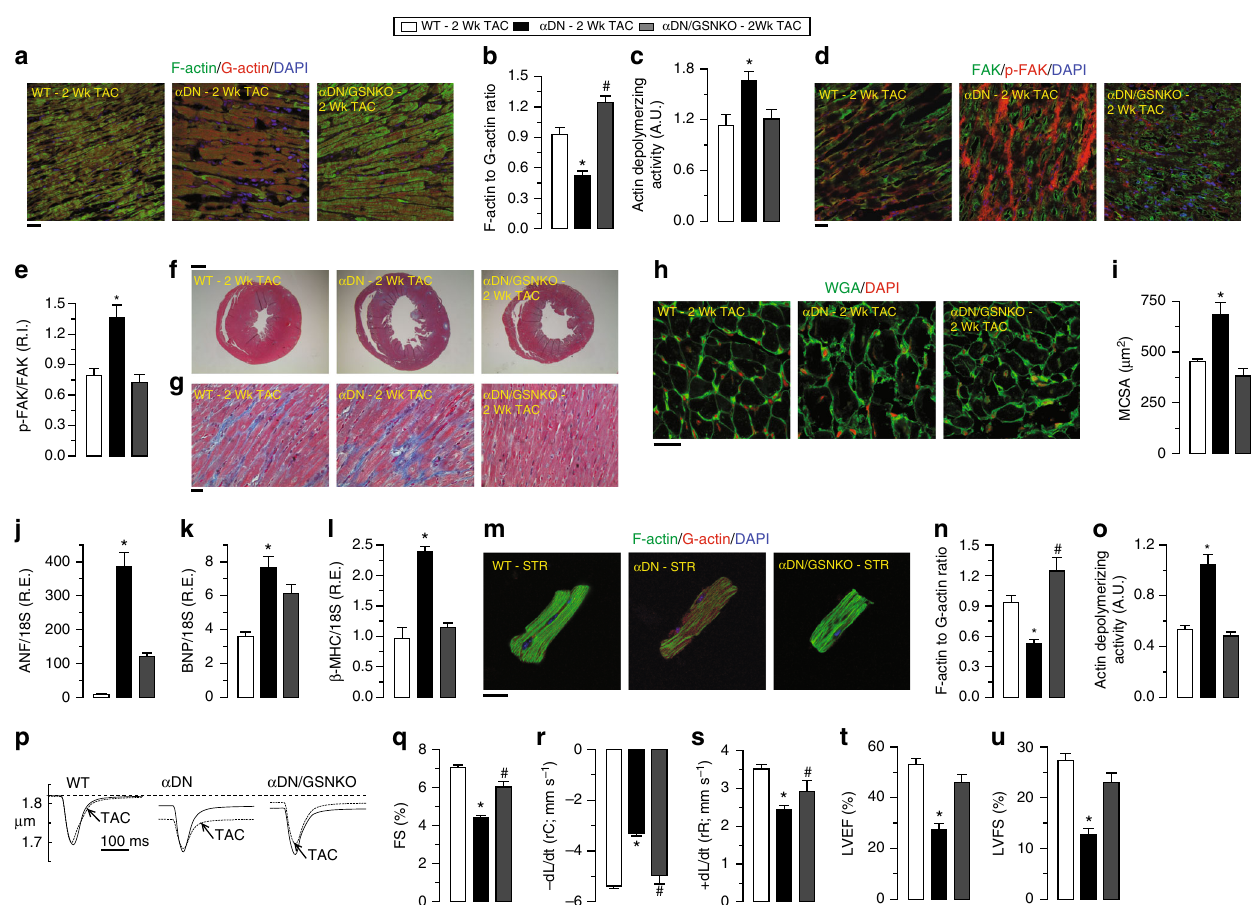
Fig. 7 Loss of gelsolin attenuates the biomechanical stress-induced cytoskeletal remodeling and preserves the cardiac function in PI3K α DN mice. a – c Representative images of F- and G-actin staining ( a ), F- to G-actin ratio ( b ), and actin-depolymerizing activity ( c ) showing pressure overload-induced dysregulation of actin fi laments (reduction of F/G-actin ratio) and increased actin-depolymerizing activity in the PI3K α DN LVs. Loss of gelsolin (in α DN/ GSNKO mice) resulted in reduced actin-depolymerizing activity and preserved actin fi lament arrangement (preserved F/G-actin ratio) in response to pressure-overload. d , e Representative IF images ( d ) and their quanti fi cation ( e ) showing attenuated phosphorylation of FAK in α DN/GSNKO hearts in response to pressure overload. f – i Masson trichrome ( f , g ) and WGA staining ( h ) showing alleviation of ventricular dilation ( f ), cardiac fi brosis ( g ), and myocyte cross-sectional area ( h , i ) in α DN/GSNKO mice compared with the α DN mice in response to pressure overload. j – l Taqman real-time PCR analyses showing attenuation of increased mRNA expression of cardiac disease markers including ANF ( j ), BNP ( k ), and β -MHC ( l ) in α DN/GSNKO mice compared with the α DN mice in response to pressure overload-induced biomechanical stress. m – o Representative images of F- and G-actin staining ( m ), F- to G-actin ratio ( n ), and actin-depolymerizing activity ( o ) showing the attenuation of increased actin-depolymerizing activity in the cardiomyocytes isolated from α DN/GSNKO LVs compared with α DN LVs subjected to cyclic stretch for 24 h. p – s Single cardiomyocyte contractility measurements ( p ) showing attenuation of decreased myo fi lament FS ( q ) and ±d L /d t ( r , s ) in cardiomyocytes isolated from α DN/GSNKO LVs compared with α DN LVs in response to pressure overload. t – u Quantitative assessment of M-mode echocardiography of LV showing preserved cardiac function in α DN/GSNKO hearts in response to pressure overload-induced biomechanical stress. Data represent means ± s.e.m. * P < 0.05 compared to all the groups, # P < 0.05 compared with α DN — 2 week TAC group as determined by one-way ANOVA analysis ( b , c , e , i – l , n , o , q – u ). Biological replicates: n = 4 ( a , b , d – i ), n = 6 ( c , m – s ), n = 10 ( j – l ) and n = 12 ( t , u ). For in vitro experiments, each biological replicate was mean of four technical replicates ( m – o ); only biological replicates are plotted and used for statistics. Scale bars show 25 µ m ( a , d , g , h , m ) and 1 mm ( f